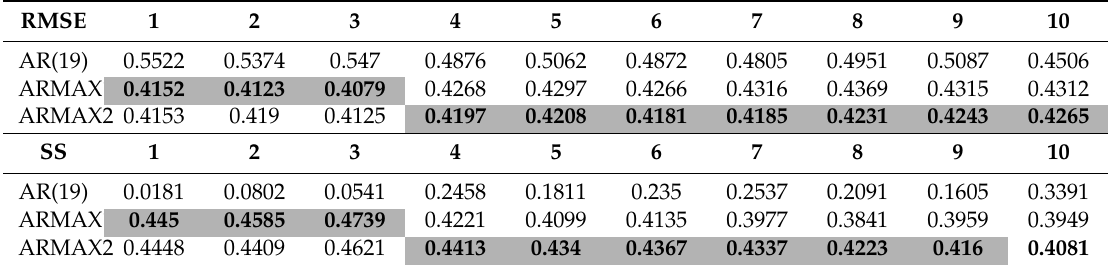
Table 2. Cross-validation results for the three models developed for the 10-year moving average data. Root mean squared error is shown on top while the skill score is shown on the bottom. The columns represent the ten forecasting horizons (h = 1, 2, ... 10). Highlighted values are the best statistic for each forecasting horizon.